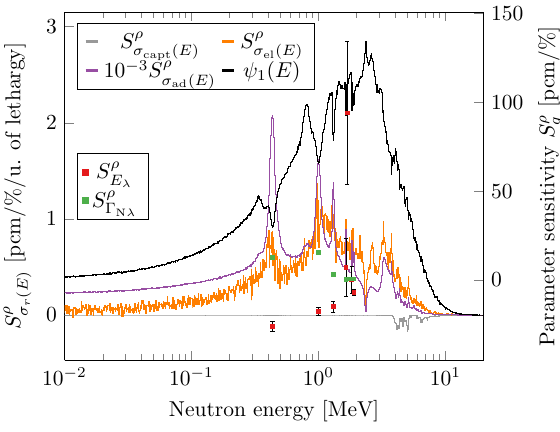
Figure 3. 16 O cross section, distribution and resonance parame- ter sensitivities for the PST001 benchmark. The neutron flux is also shown in arbitrary unit.